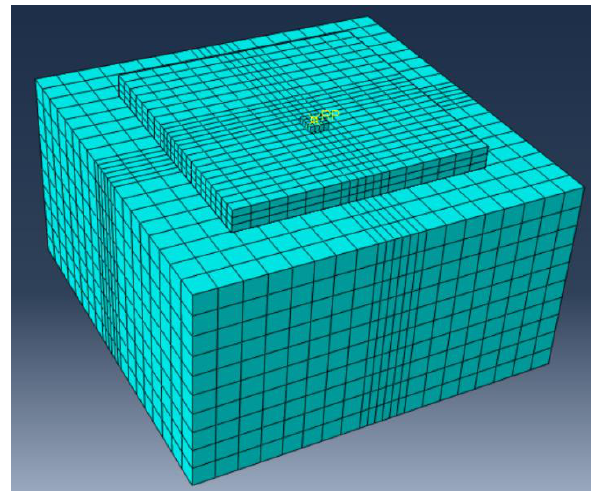
Figure 7. Meshing of the model.